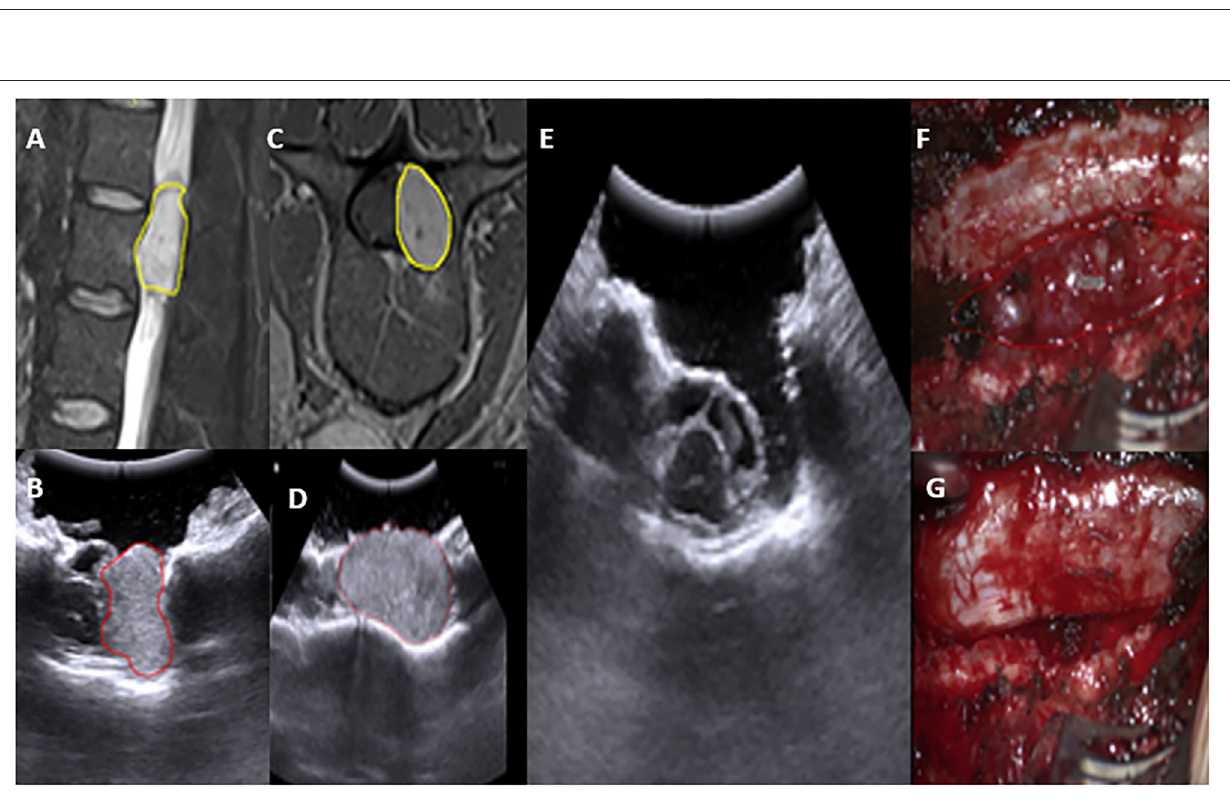
that the rate at which different surgeons will acquire the skill to effectively employ iUS is largely a function of their years of surgical experience (2,